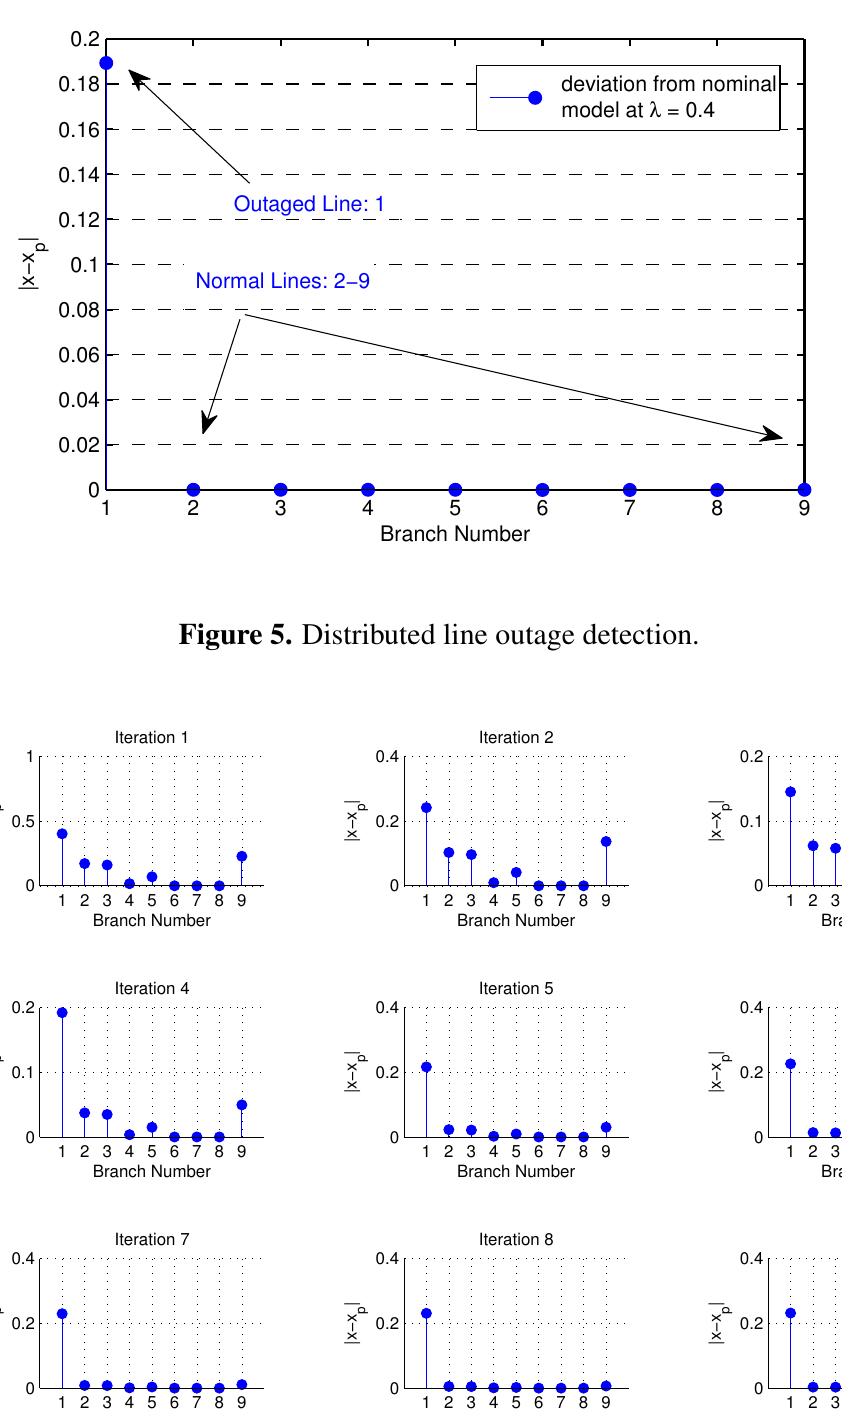
Figure 4. Centralized line outage detection.